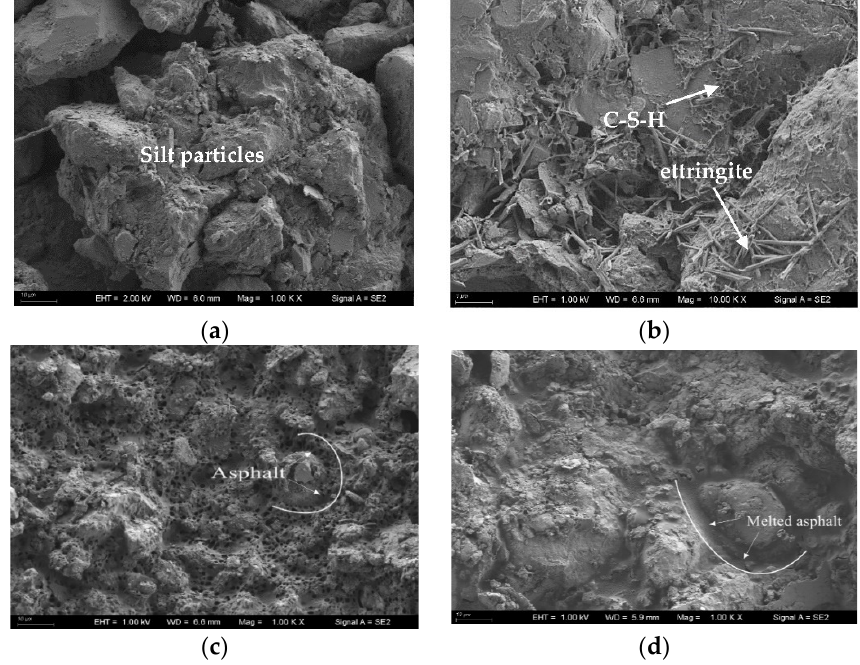
Figure 15. SEM morphology photographs of different samples. ( a ) Silt; ( b ) Cement stabilized silt; ( c ) Flexible curing agent stabilized silt; ( d ) Flexible curing agent stabilized silt after heating.